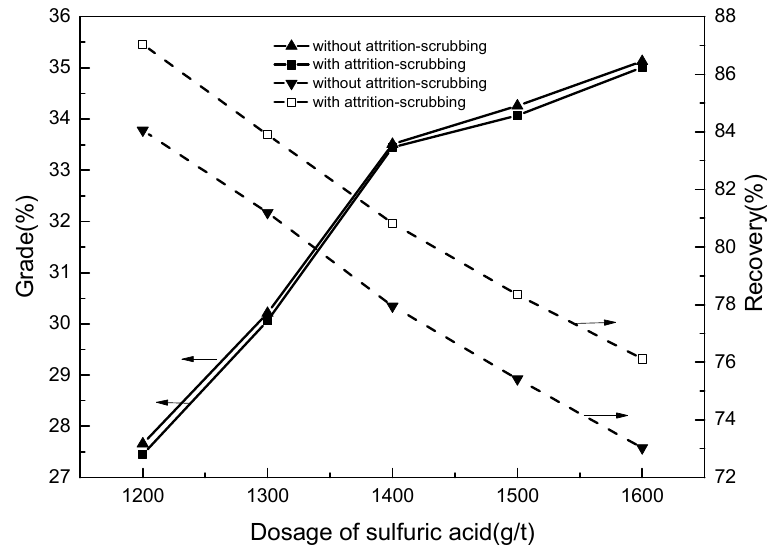
Figure 4. The results of sulfuric acid dosage on the flotation behaviors of ilmenite.